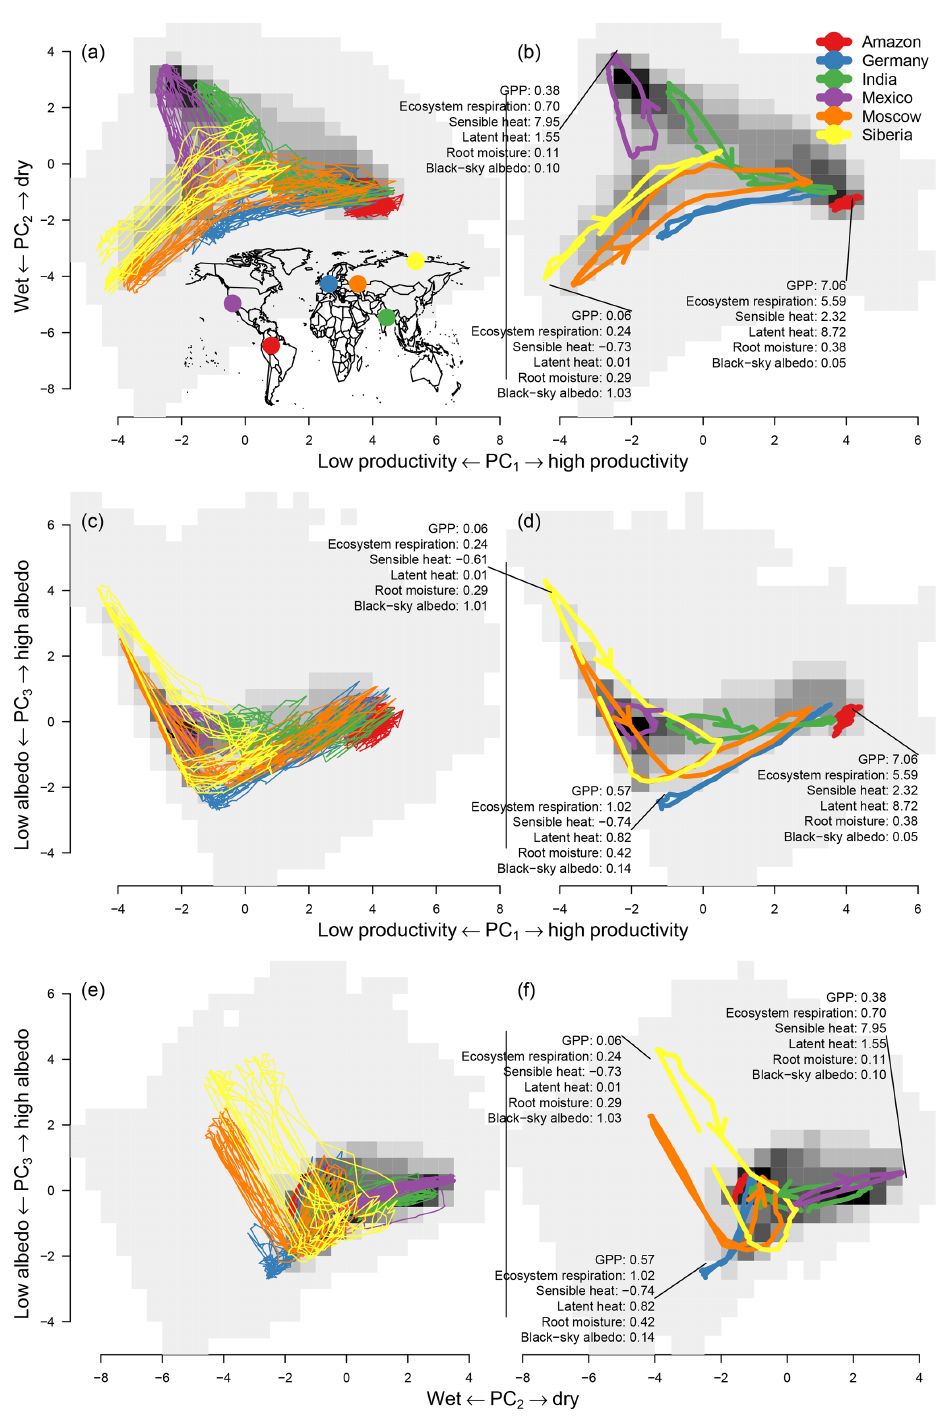
Figure 4. Trajectories of some points (colored lines) and the area-weighted density over principal components one and two (the gray back- ground shading shows the density) for (a, c, e) the raw trajectories and (b, d, f) the mean seasonal cycle. The trajectories are shown in the space of PC 1 –PC 2 (first row), PC 1 –PC 3 (second row), and PC 2 –PC 3 (third row). The trajectories were chosen to cover a large area in the space of the first two principal components. Some of the trajectories have an arrow indicating the direction. The numbers illustrate the value of some variables; for units see Table 1. Description of the points is as follows. Red: tropical rain forest, 2.625 ◦ S, 67.625 ◦ W; blue: maritime climate, 52.375 ◦ N, 7.375 ◦ E; green: monsoon climate, 22.375 ◦ N, 82.375 ◦ E; purple: subtropical, 34.875 ◦ N, 117.625 ◦ W; orange: continental climate, 52.375 ◦ N, 44.875 ◦ E; yellow: arctic climate, 72.375 ◦ N, 119.875 ◦